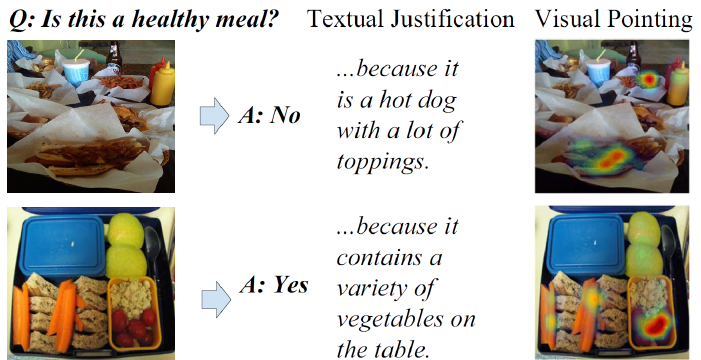
Figure 13. Multimodal Explanation ( ME ) [97] explains by two types of justifications of visual question answering task: The example shows two images with food, and the question is if they contain healthy meals or not. The explanations of the answers “yes” or “no” are given textually in justifying in a sentence and visually in pointing out the most responsible areas of the image.